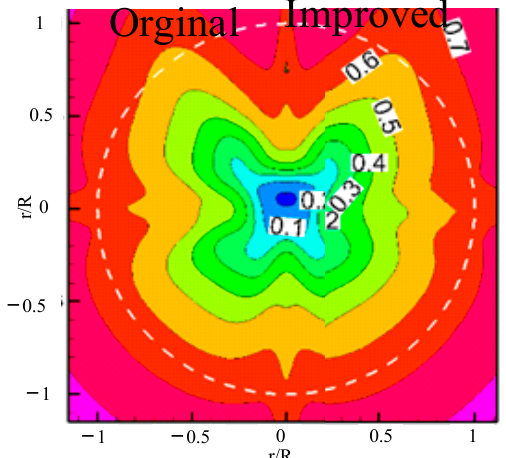
Figure 8. Distribution of the axial velocity.